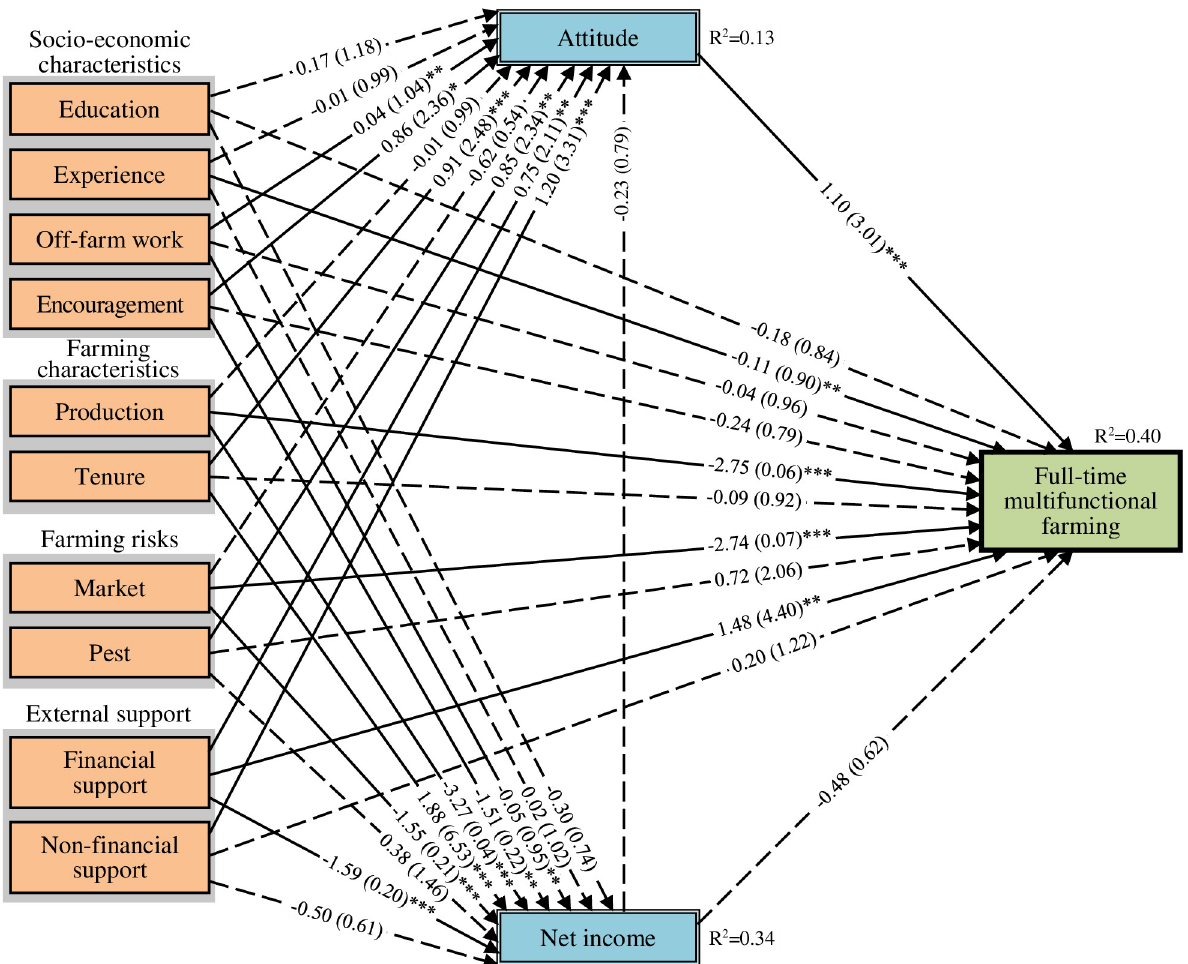
Fig 7. Path diagram of result of generalised structural equation modelling for full-time multifunctional farming. Notes: 1) number of full-time multifunctional farmers = 40, 2) number of samples (n) = 176, 3) � , �� , ��� significant at 10%, 5%, and 1% levels, 4) Dashed lines represent statistically insignificant path coefficients, 5) Numbers in the brackets were odds ratios, and 6) Second-order bias-corrected Akaike information criterion (AICc) = 830.97.